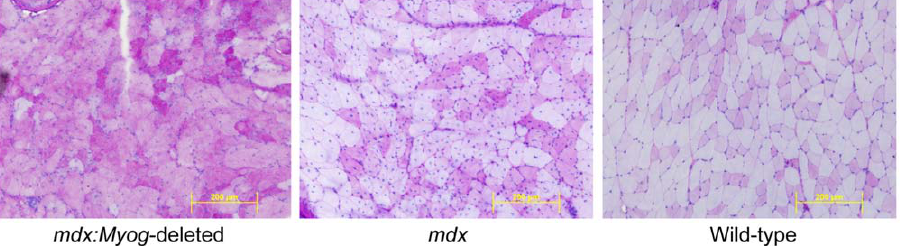
Figure 7. Similar muscle glycogen content in mdx and mdx:Myog -deleted mice. Glycogen staining showed similar levels of glycogen in mdx and wild-type gastrocnemius muscles, but suggested that mdx:Myog -deleted muscle had an increased trend towards glycogen